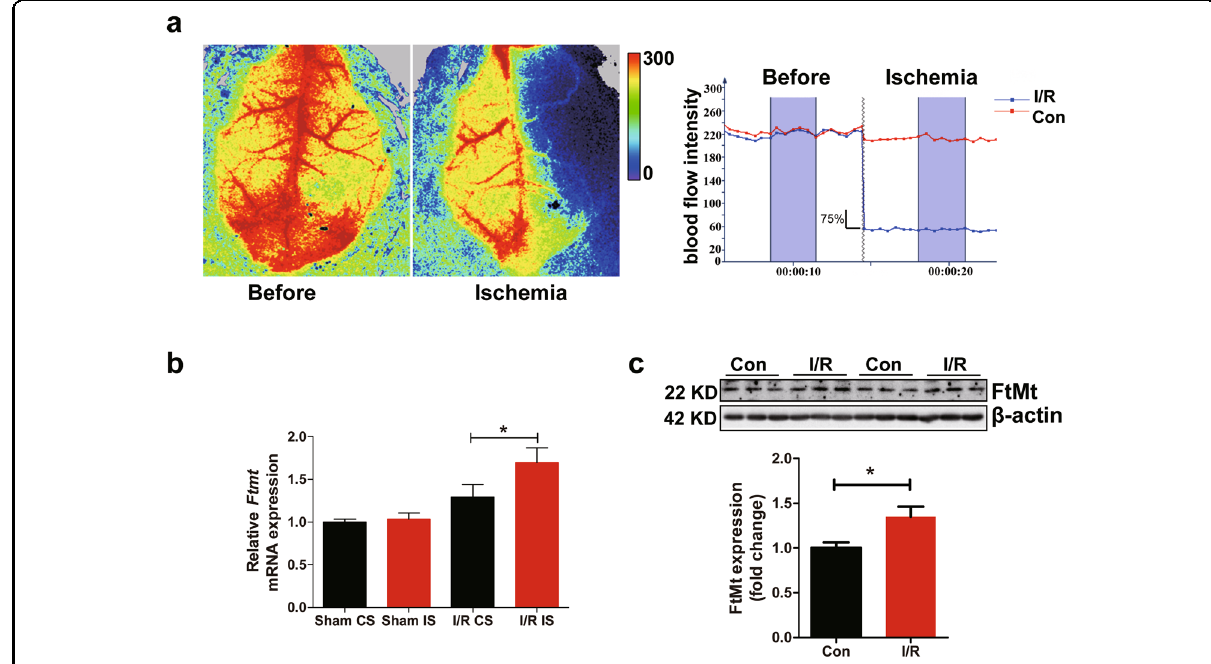
Fig. 1 Upregulation of FtMt in the I/R brains of mice. a Ischaemic stroke was induced by MCAO for 90 min with a subsequent 24 h reperfusion period. Blood fl ow was detected by laser Doppler fl owmetry during MCAO. b Relative mRNA expression of Ftmt in operated mice or sham-operated controls. The mRNA levels were normalized to β -actin mRNA levels and are expressed relative to the mean value in the sham control side. CS, control side; IS, injured side. c Western blot analyses showing the induction of FtMt in the penumbra after 24 h of reperfusion. The results are normalized to the β -actin levels. I/R, penumbral area in the cortex of the ipsilateral hemisphere; Con, same area in the penumbra in the cortex of the contralateral hemisphere. The results are presented as the mean ± SEM ( n = 6). * P <